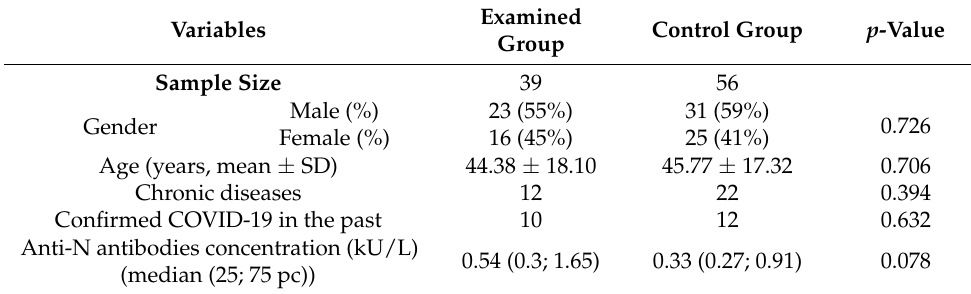
Table 1. Characteristic of